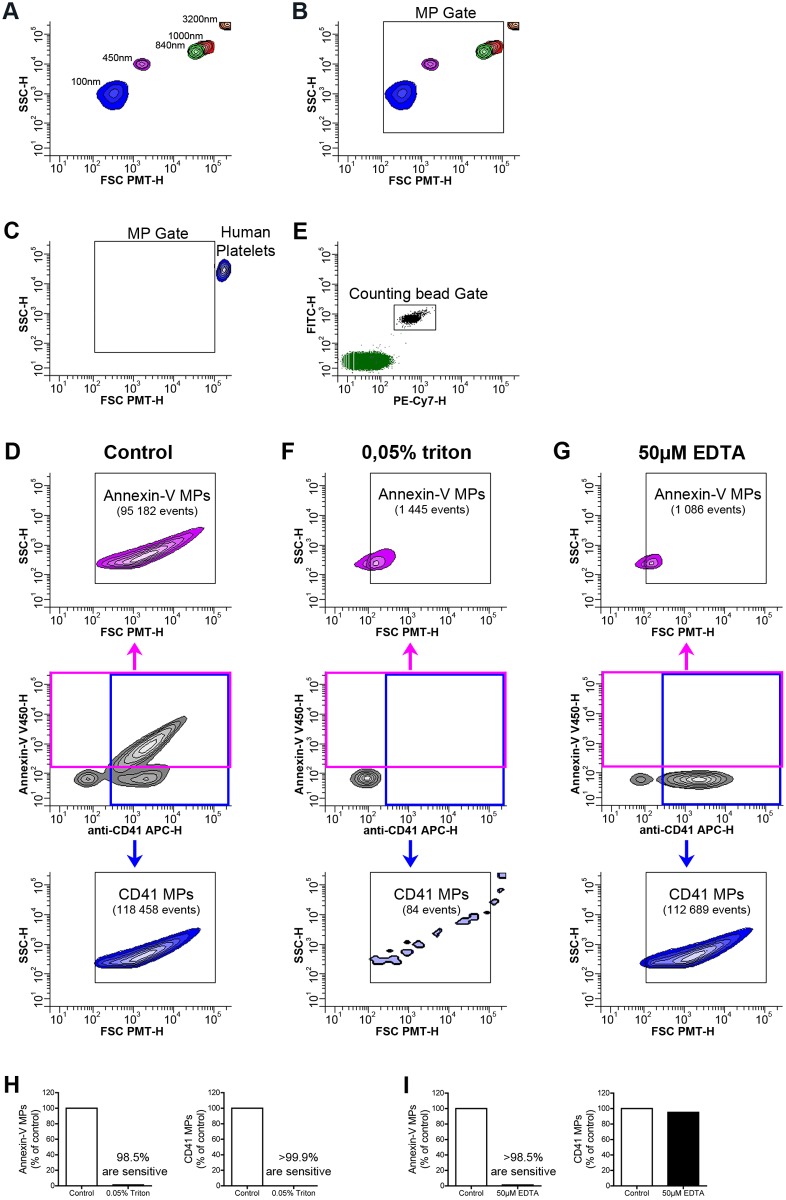
Optimization of flow cytometric methods for the detection of MPs.(A, B) Acquisition of fluorescent microspheres of 100nm (Blue), 450nm (pink), 840nm (green), 1000nm (red), 3200nm (orange) in diameter on a flow cytometer Canto II modified with a FSC-PMT small particles option. (B) A MP gate including particles from 100 to 1000nm in diameter based on the microsphere sizes (FSC-PMT-H) is presented and used to detect MPs. (C) Portrayal of relative size of human platelets detected with fluorochrome-conjugated antibodies directed against CD41. (D) FSC-PMT/SSC portrayal of platelet MPs detected with annexin-V and fluorochrome-conjugated antibodies directed against CD41 in absence of treatment (control). (E) A known concentration of auto-fluorescent polystyrene microspheres (15 µm in diameter) was added in each tube and a determined number of beads was acquired in the counting bead gate to quantitatively process the data. (F, G) FSC-PMT/SSC portrayal of platelet MPs detected with annexin-V and fluorochrome-conjugated antibodies directed against CD41 and treated with 0.05% triton (F) and 50µM EDTA (G). Total annexin-V+ events are detected in the pink gate (middle panel) and the quantity of annexin-V+ MPs is determined in the Annexin-V MP gate (upper panel). Total CD41+ events are detected in the blue gate (middle panel) and the quantity of CD41+ MPs is determined in the CD41 MP gate (lower panel). Data are representative of 5 independent experiments. (H) Triton sensitivity of the platelet MPs detected using fluorochrome-conjugated annexin-V (left panel) and fluorochrome-conjugated antibodies directed against CD41 (right panel) is presented as % of untreated (control). (I) EDTA sensitivity of annexin-V (left panel) and CD41 (right panel) labeling is presented as % of untreated (control). Data are representative of 5 independent experiments.